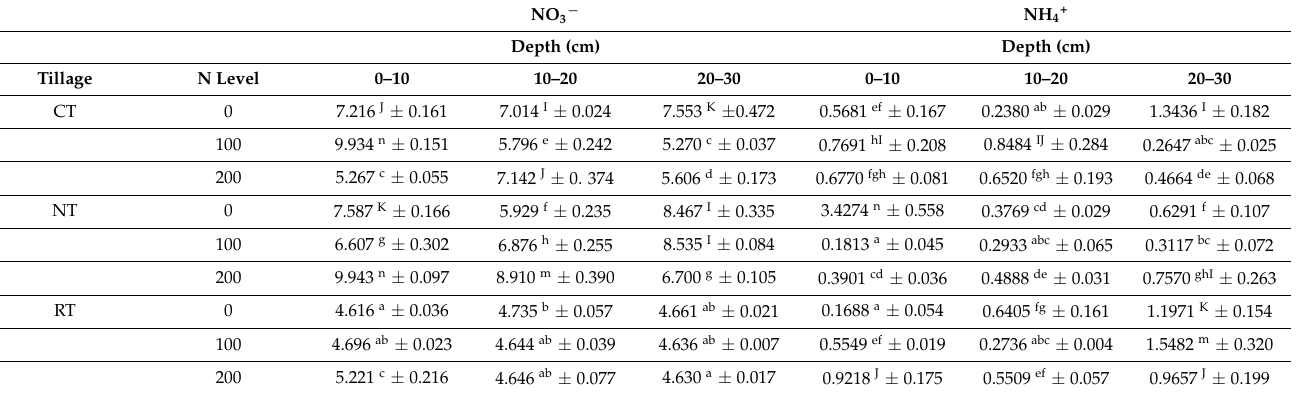
Table 4. Concentrations of NO 3 − and NH 4 + (mg/kg) and standard errors of means found under different tillage treatments, sampling depths, and N fertiliser application